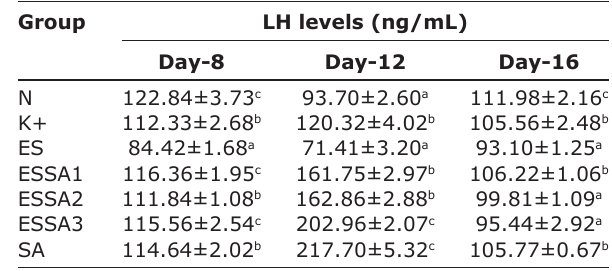
Table-1: Effect of combined ES and SA ethanol extract on FSH levels of the experimental mice. Group